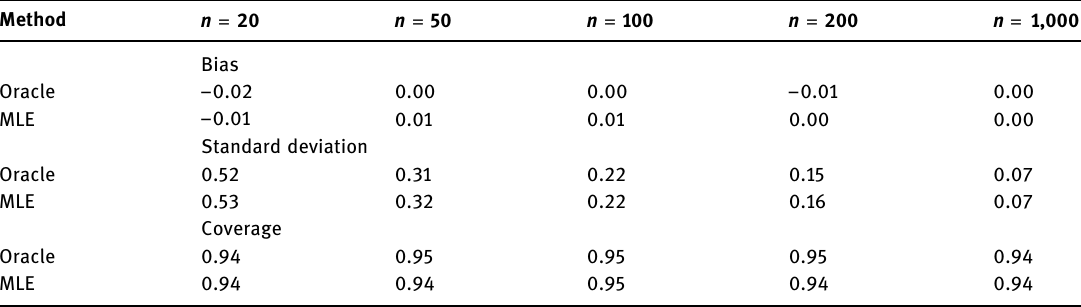
Table A3: Results of simulation scenario 3S comparing oracle GBCEE to MLE GBCEE Method